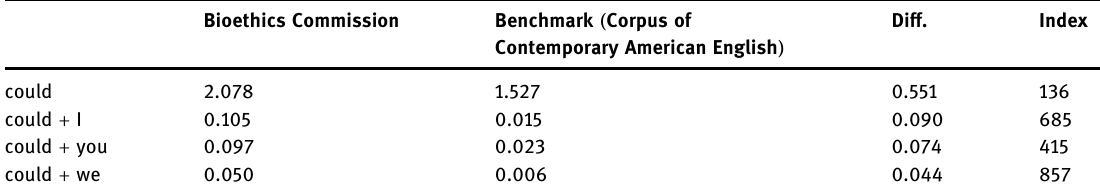
Table 23: “ Could ” collocations with pronouns, as per cent of total tokens ( normalised, n = 1,000